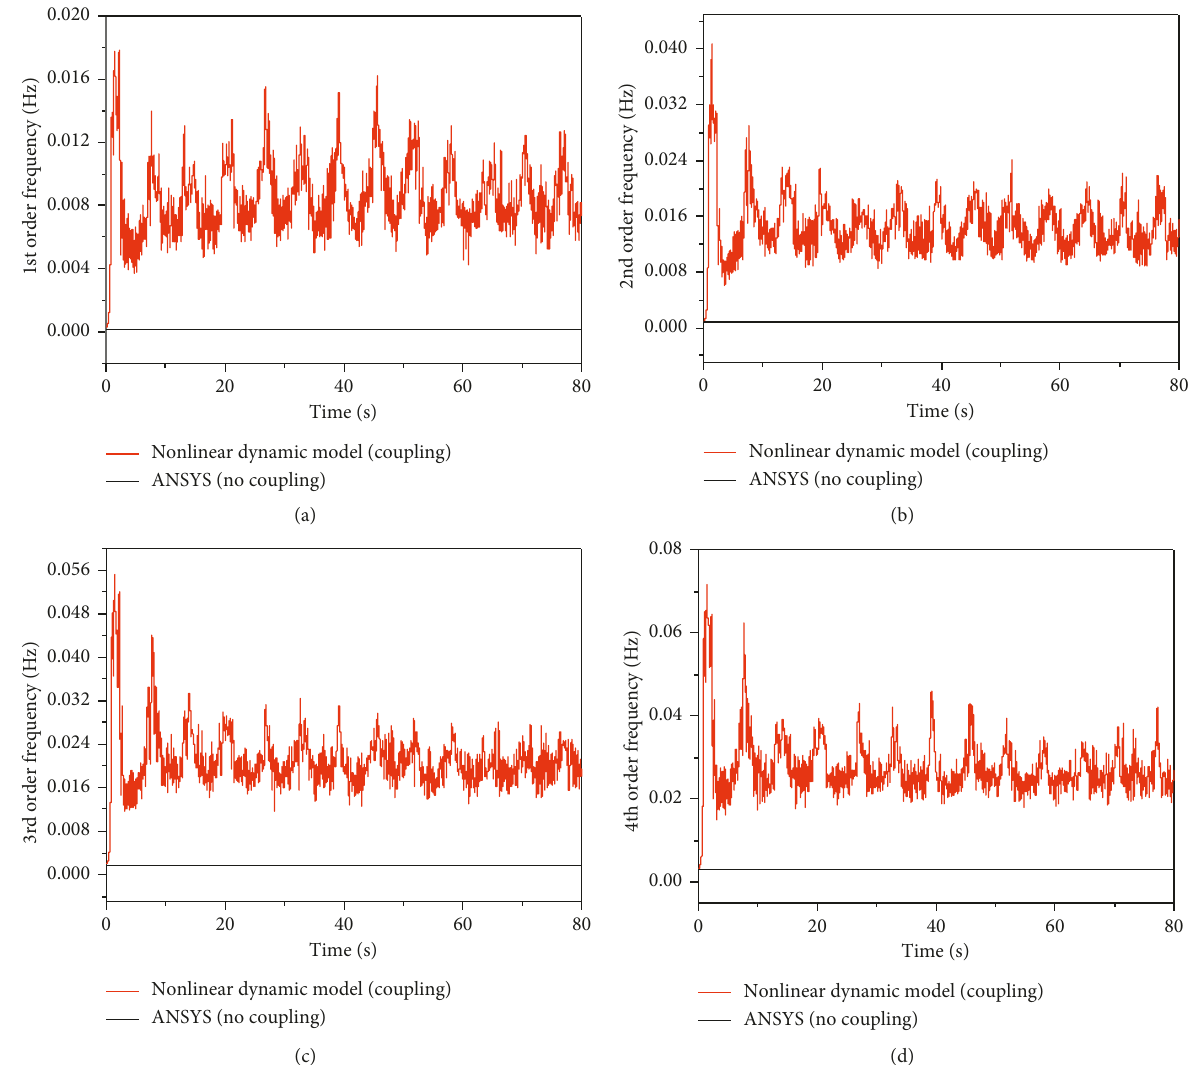
Figure 6: The four order natural frequency responses: (a) first order; (b) second order; (c) third order; (d) fourth